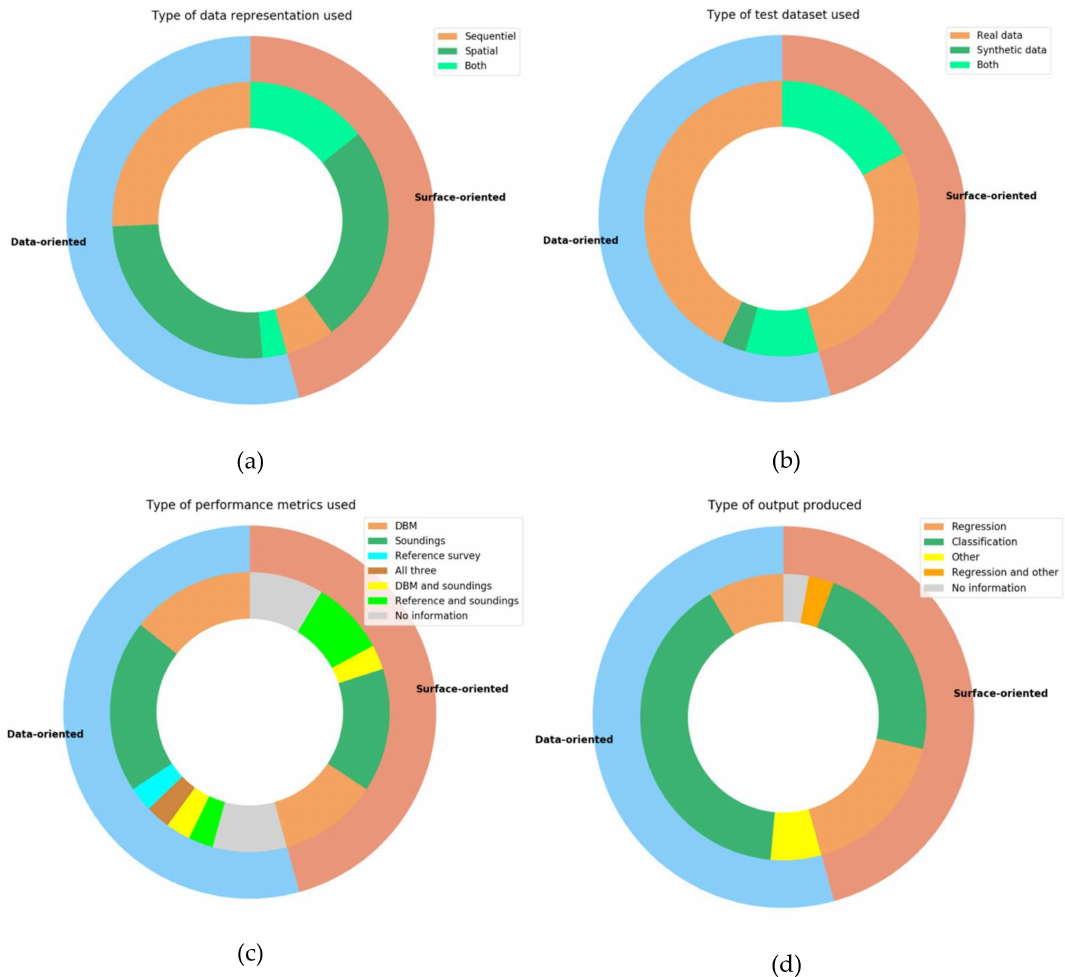
Figure 9. ( a ) Type of data representation per article; ( b ) type of dataset per method; ( c ) type of metrics performance used for each article; ( d ) output information given by the